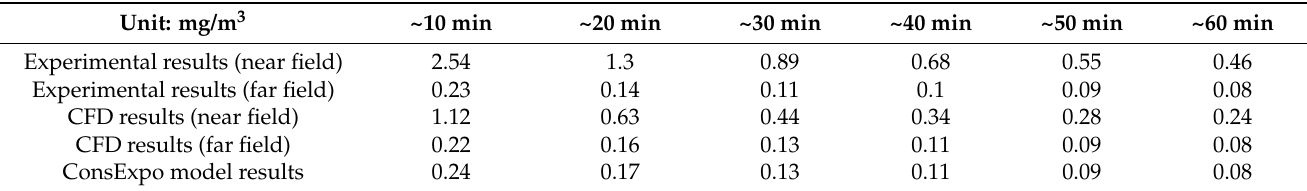
Figure 7. The comparison results of experimental results, zero-dimensional spray simulation (ConsExpo simulation) and CFD simulation in near field and far field. ( a ) Far field comparison results, ( b ) near field—far field comparison results. Table 4. Time-weight averaged aerosol concentration for experimental results in near field and far field, CFD results in near field and far field and ConsExpo